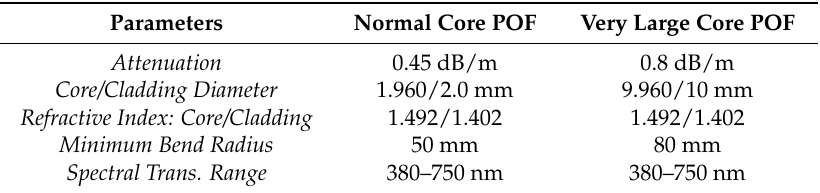
Table 2. POF parameters for design and